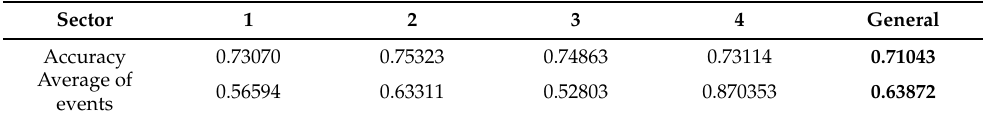
Table 5. Results of the general classification